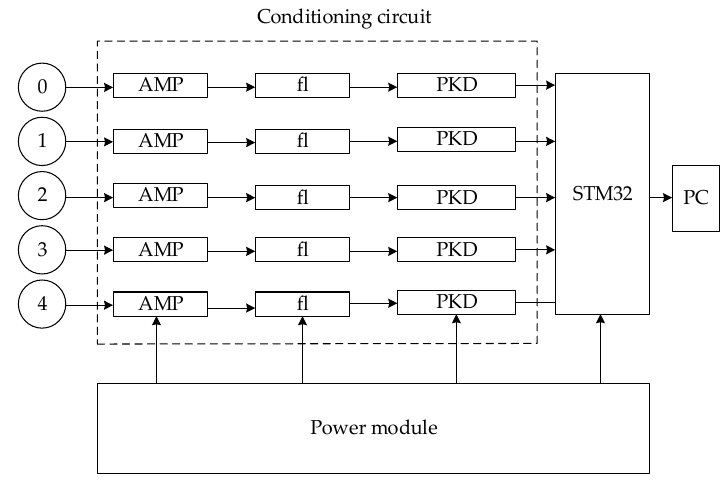
Figure 8. Detector circuit block diagram.